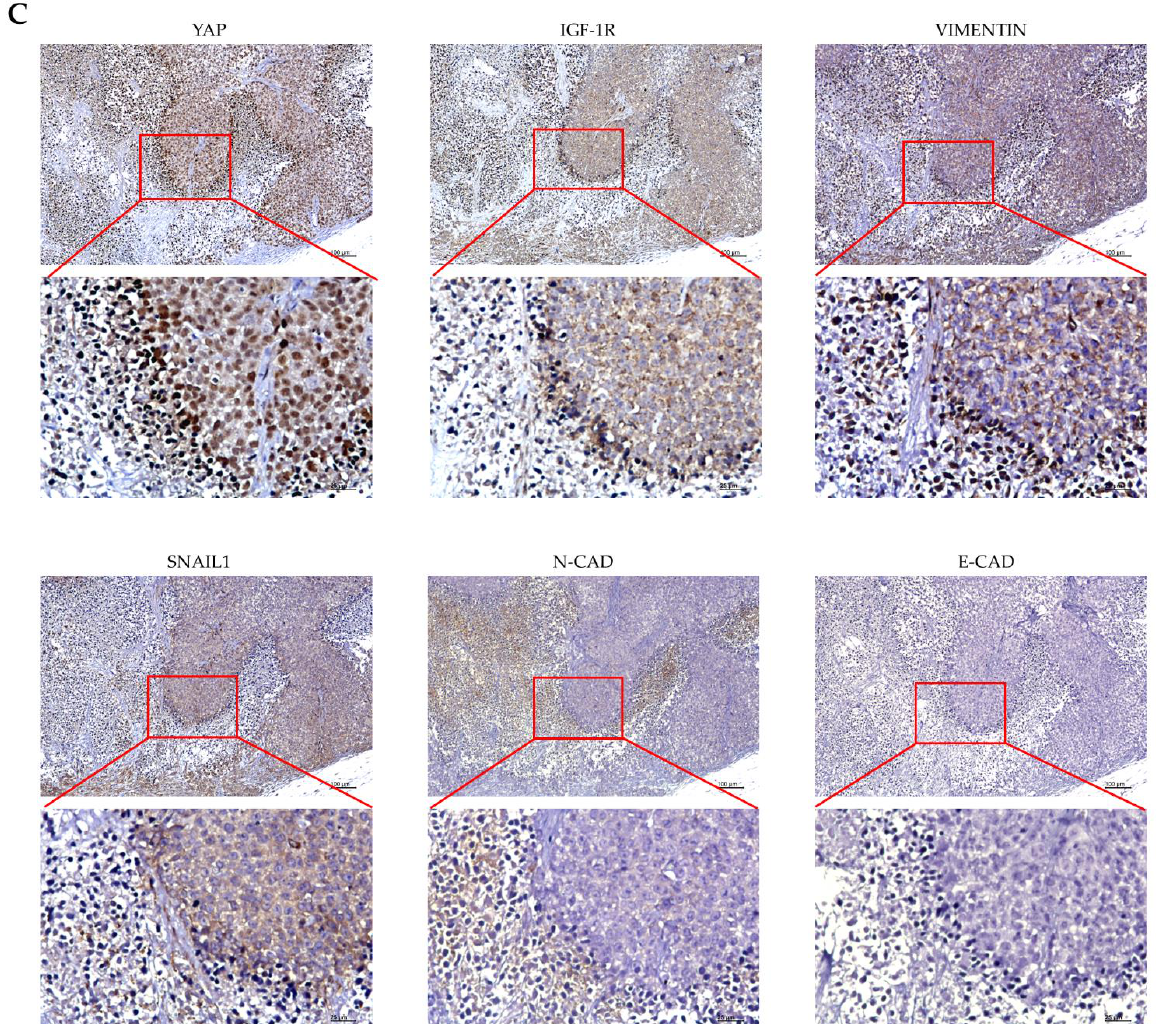
Figure 2. High association of YAP with IGF-1R and EMT-related proteins in sorafenib-resistant HCCs. Expression levels of ( A ) mRNA and ( B ) protein of YAP, IGF-1R, and EMT markers in naïve/resistant HepG2215 and HepG2215_R cells. Data are the mean ± SEM of at least three independent experiments. ** p < 0.01, *** p < 0.001, and **** p < 0.0001 by Student’s t -test. ( C ) Immuno-histochemical staining of expression and cellular localization of YAP, IGF-1R, and EMT markers (VIMENTIN, SNAIL1, and N-CAD) in xenograft of HepG2215_R tumor tissue in sorafenib-treated SCID mice. Scale bar, 100 µm.